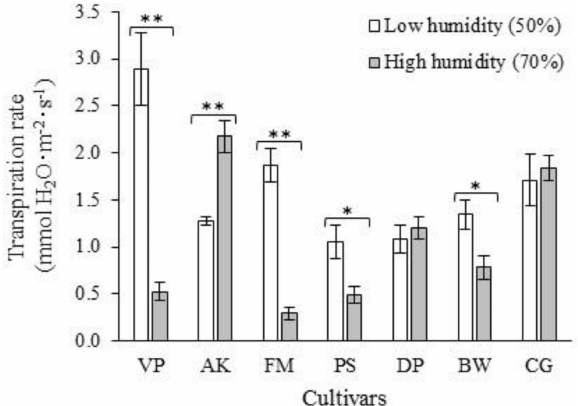
Figure 3. Mean transpiration rates of the maximum leaf in seven lisianthus cultivars under low and high air humidity treatments. Cultivars are arranged in order of mean transpiration rates for the low and high humidity treatments. Error bars represent SE ( n = 12). * Represents significant differences between results for the low and high humidity treatments (Student’s t -test: * p < 0.05, ** p <